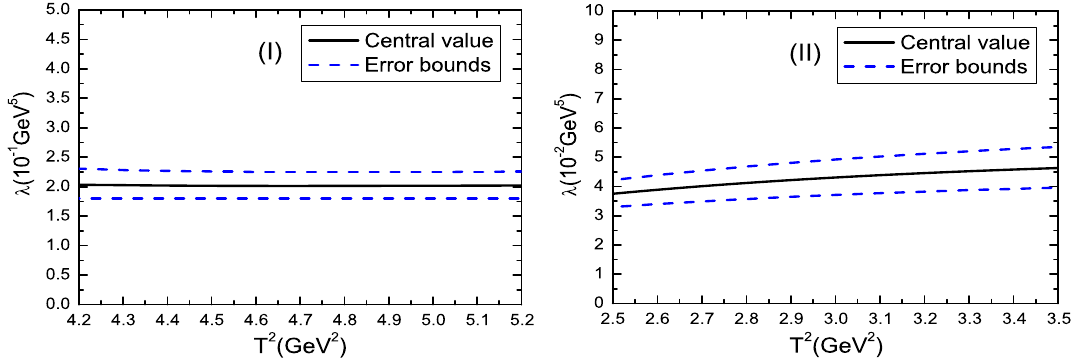
Fig. 2 The pole residues of the axialvector tetraquark states with variations of the Borel parameters T 2 , where the (I) and (II) correspond to the currents J 1 μ ( x ) and J 2 μ ( x ) ,